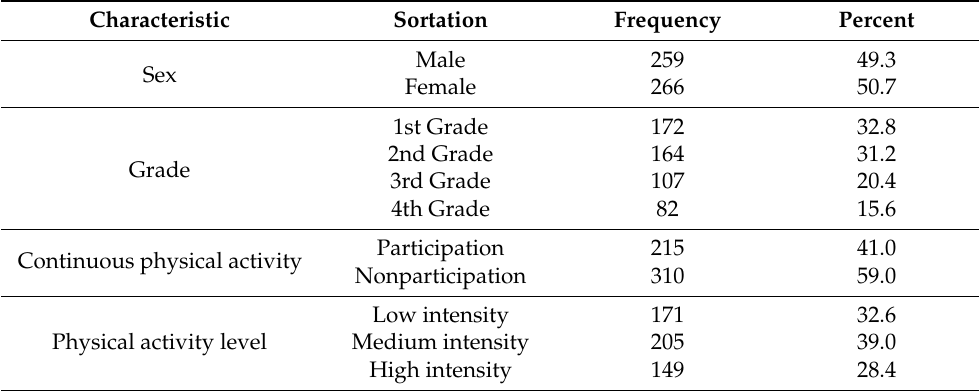
Table 1. Physical characteristics of the study participants ( n = 525) CDC (Centers for Disease Control).